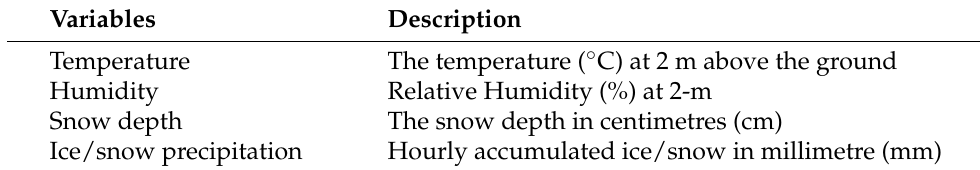
Table 2. The weather variables of interest.